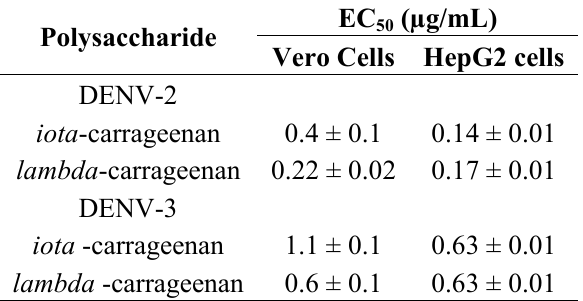
Table 1. EC values for inhibition of DEN-2 and DENV-3 multiplication in Vero and 50 HepG2